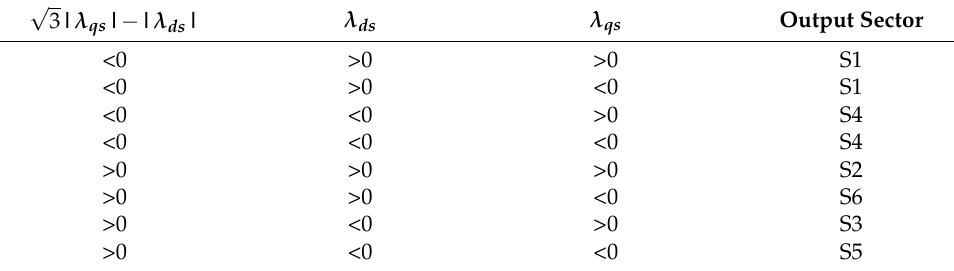
Table 1. Sector selection of the proposed MPDTC